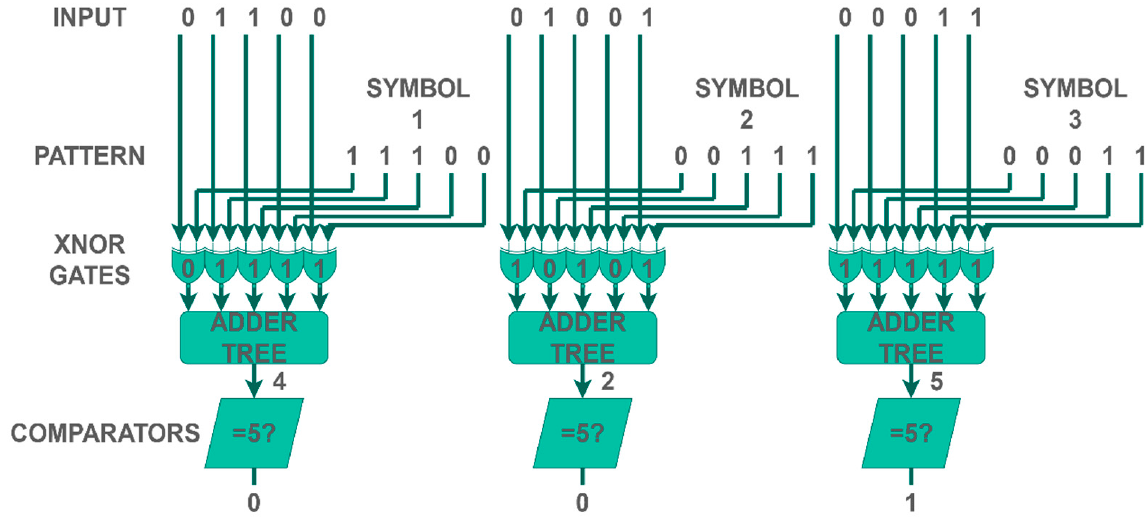
Figure 2. The lesser pattern identifier.